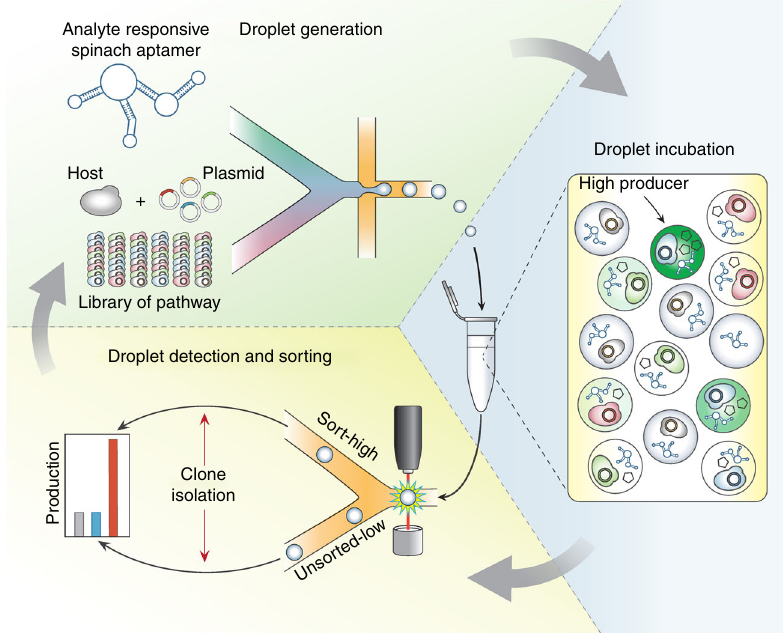
Fig. 1 Overview of RAPID Screening. RNA-aptamers-in-droplets (RAPID) screening uses analyte-responsive RNA aptamers grafted to the Spinach aptamer backbone to detect analyte concentrations in microdroplets. The aptamer is co-encapsulated with a member of a yeast mutant library and incubated to produce the molecule of interest and develop a fl uorescence signal. Droplets then fl ow through a micro fl uidic device and are sorted based on fl uorescence using dielectrophoresis. Improved variants are recovered and the evolution cycle can be repeated if